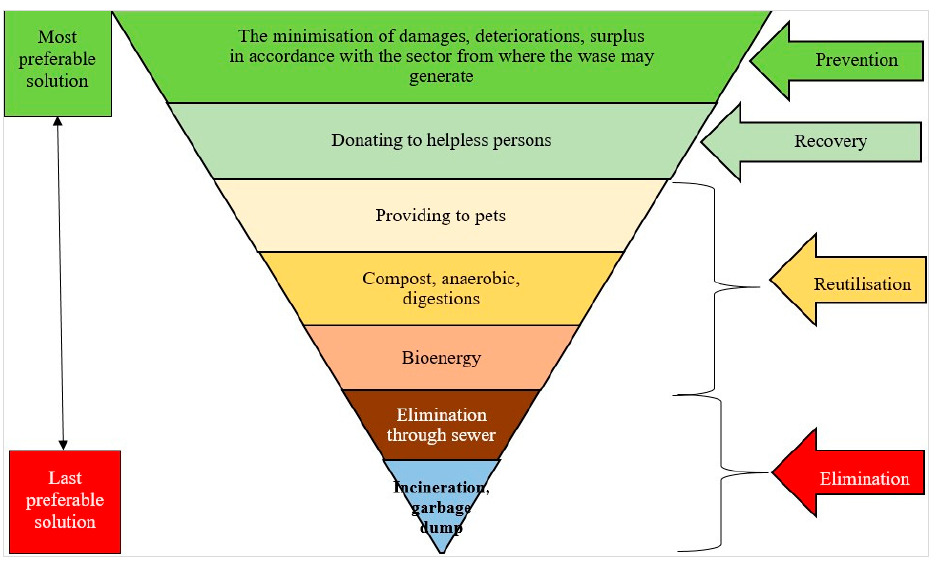
Figure 3. Food waste scale, adapted after